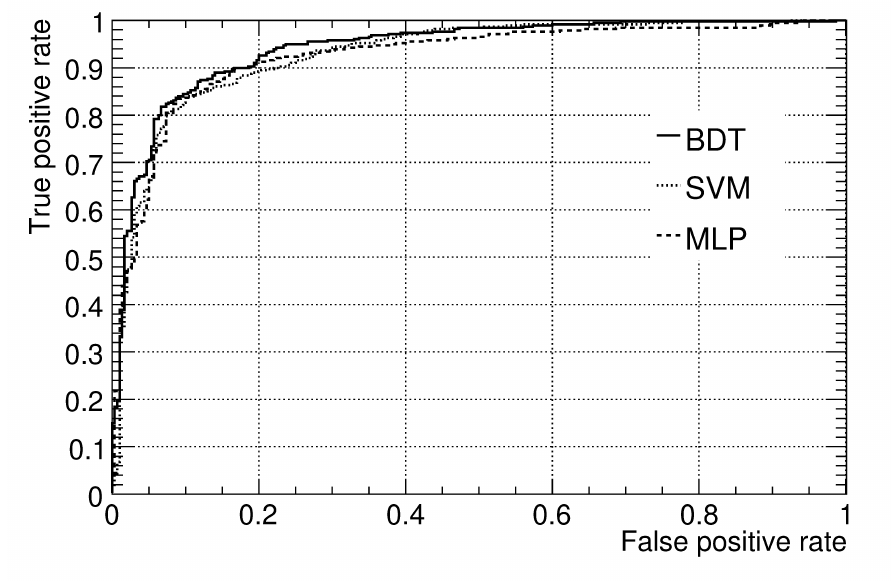
Figure 3. Receiver operating characteristics (ROC) curve for the multilayer perceptron (MLP), support vector machine (SVM) and boosted decision trees (BDT), for the Australian credit